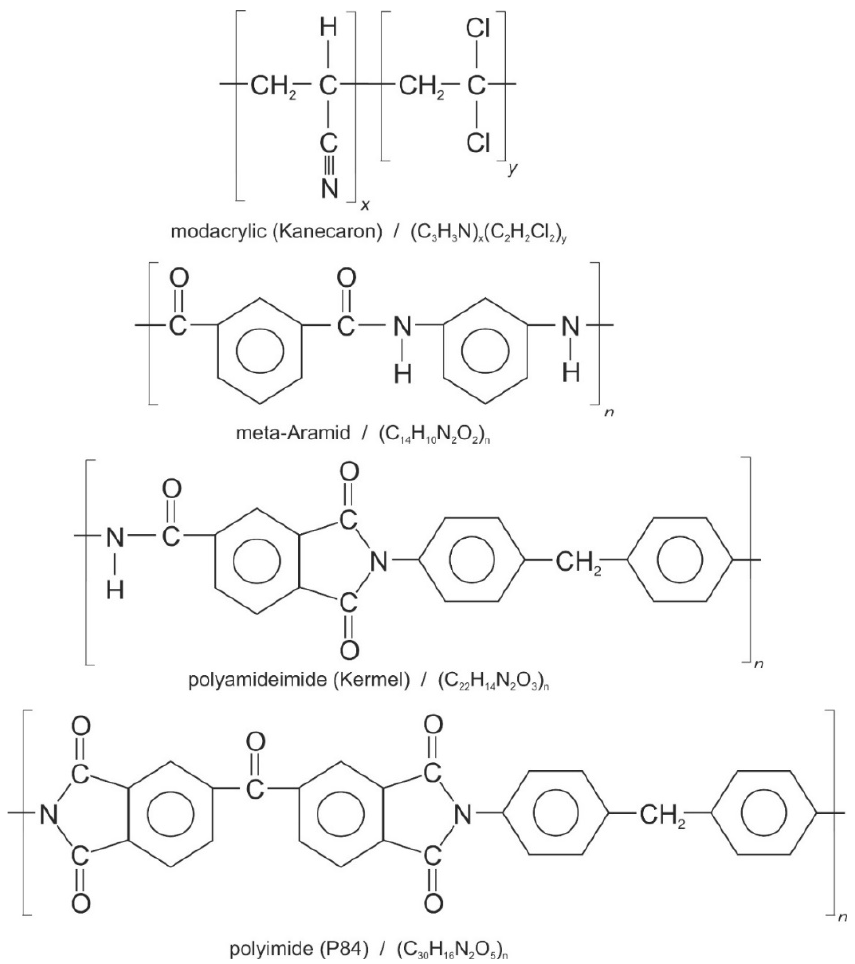
Figure 15. Chemical structures and sum formulas of high-performance fibers with fire-resistant properties.